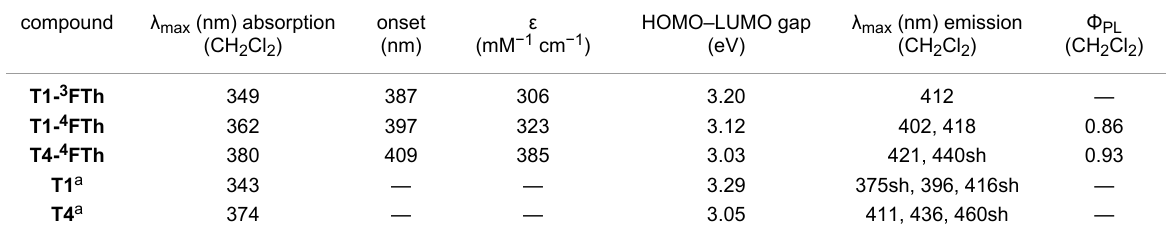
a Values obtained from [14].